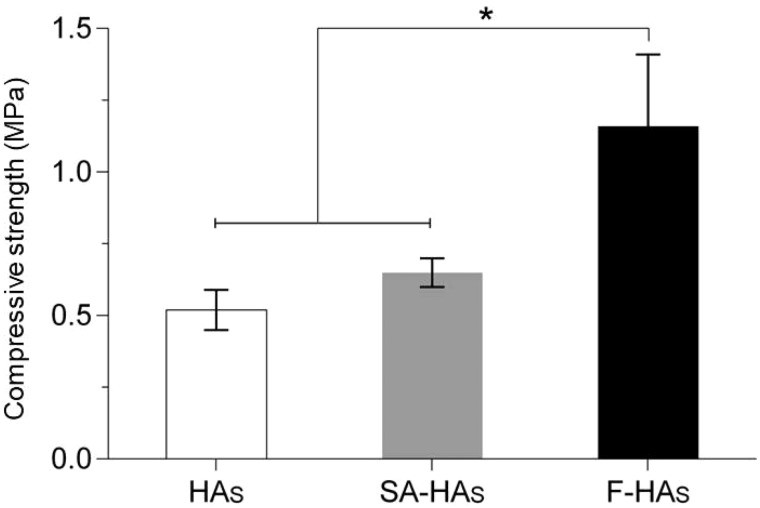
Compressive strengths of scaffolds (n = 9)